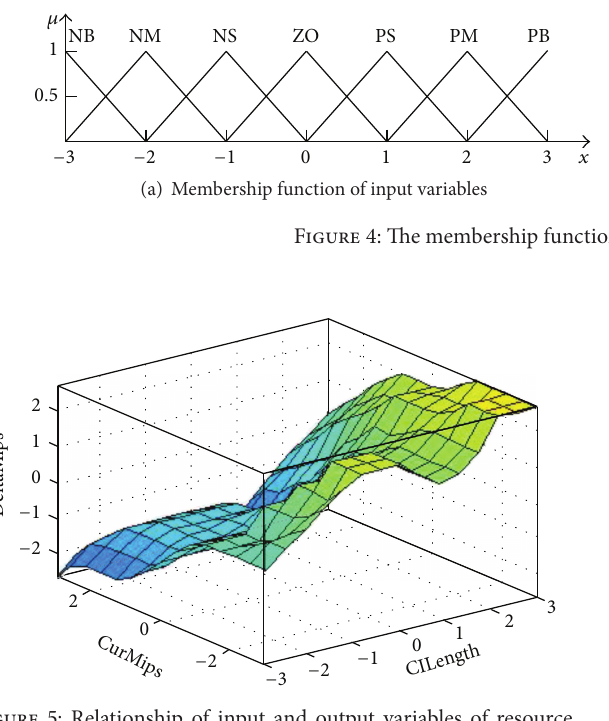
Figure 5: Relationship of input and output variables of resource scheduling algorithm.